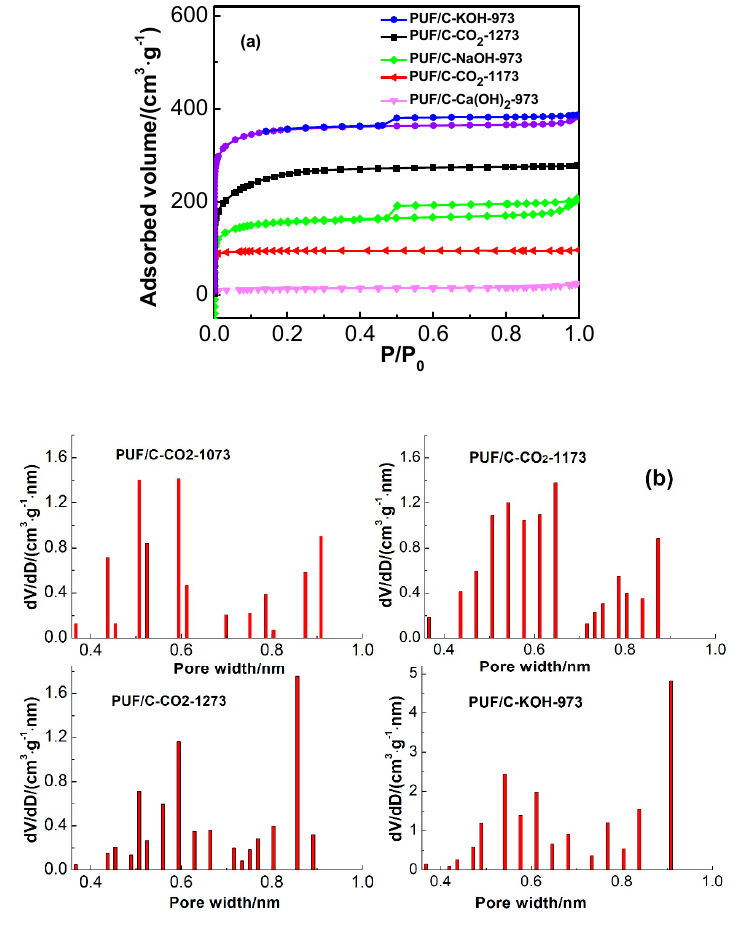
Figure 7. Adsorption isotherms of N 2 at 77 K ( a ) and pore size distributions determined by the Dubinin–Radushkevich equation applied to Table 2 adsorption data at 273 K ( b ) of the obtained samples prepared by physical and chemical activation.